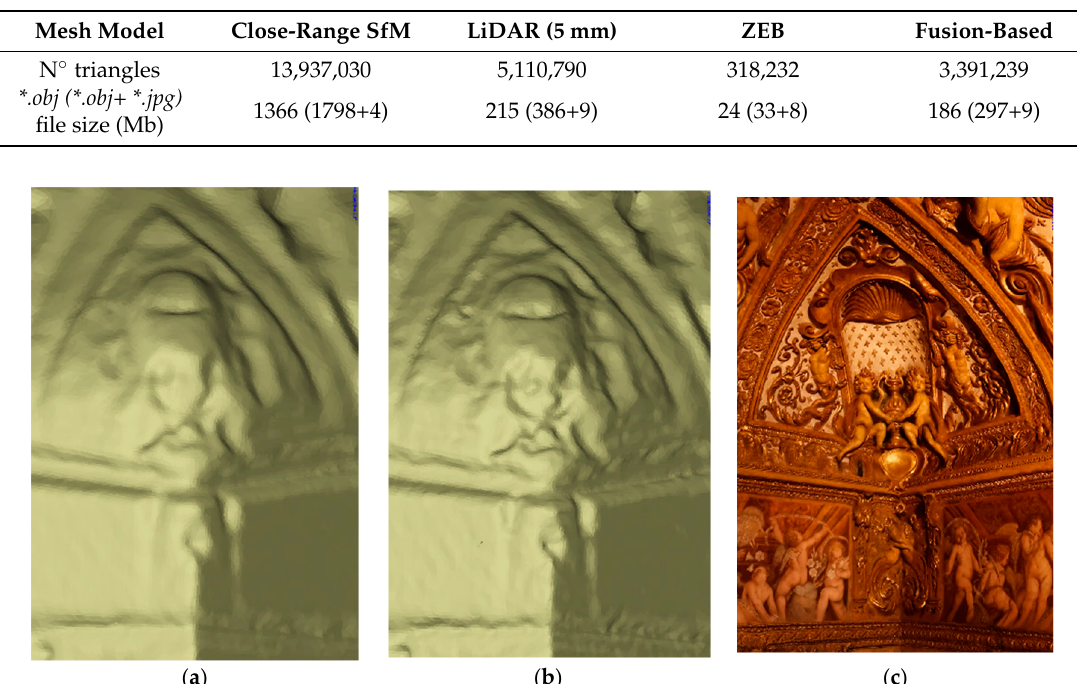
Figure 20. The ZEB-based surface reconstruction: ( a ) mesh processed with normal data computed with 15 mm radius and ( b ) computed with 5 mm; and, ( c ) with an HQ texture map applied on the (b) surface. Table 10. Results of mesh triangulation process, based on different sensors point clouds.